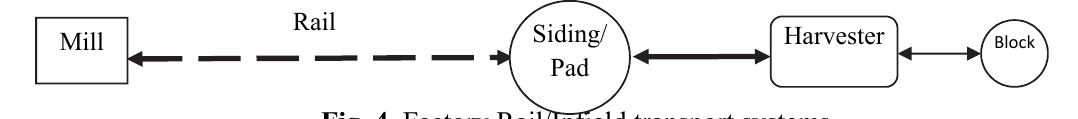
Fig. 4 . Factory Rail/Infield transport